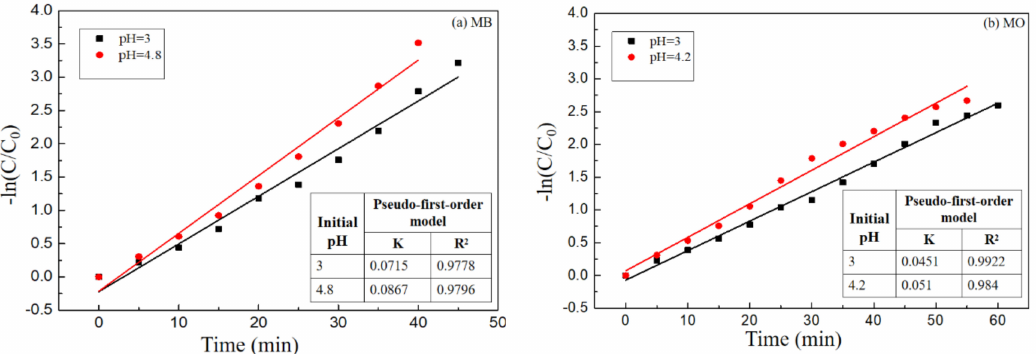
Figure 15. Oxidation kinetic of ( a ) MB and ( b ) MO degradation according with the pseudo-first-order equation